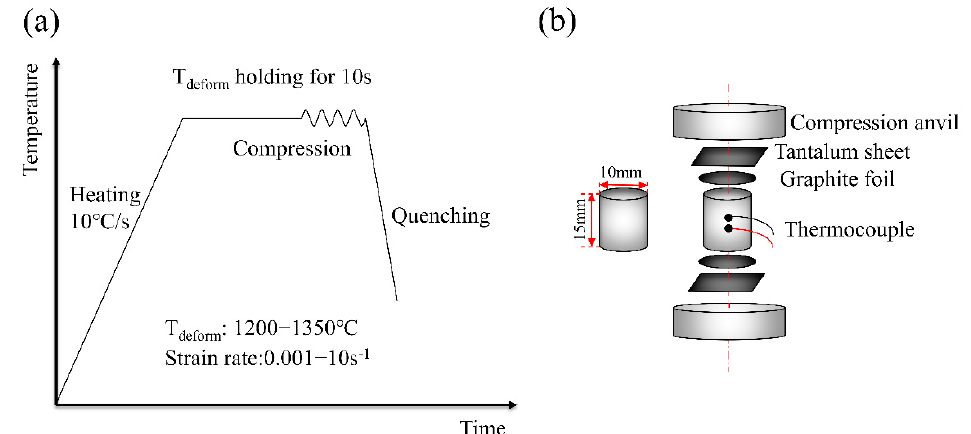
Figure 1. ( a ) Hot compression experiment procedure diagram and ( b ) schematic illustration of the hot compression test.